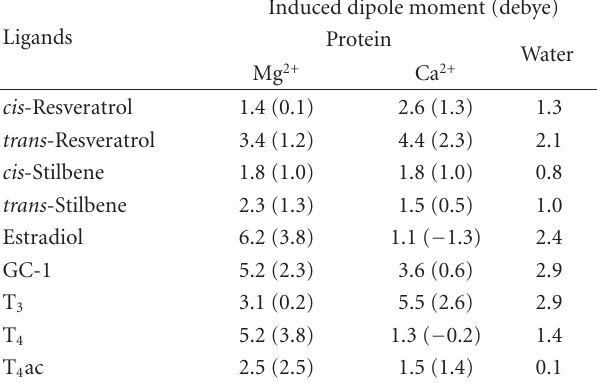
Table 2: The induced dipole moment of the ligands (Figure 2) bound in the protein (water). Numbers in parenthesis indicate the induced dipole moment of the ligand in the protein relative to the induced dipole moment of this molecule in water. The induced dipole moment is calculated as a di ff erence between the permanent dipole moment of the ligand in the protein (water) and the permanent dipole moment of this molecule in the gas phase, for the optimal geometry of this molecule in the protein (water) and the gas phase,